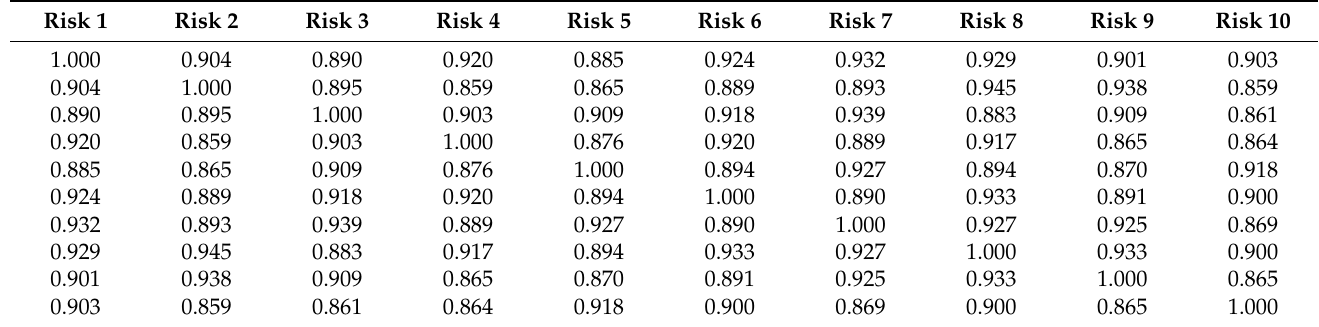
Table 1. Correlation matrix for generating correlated lognormal risks.